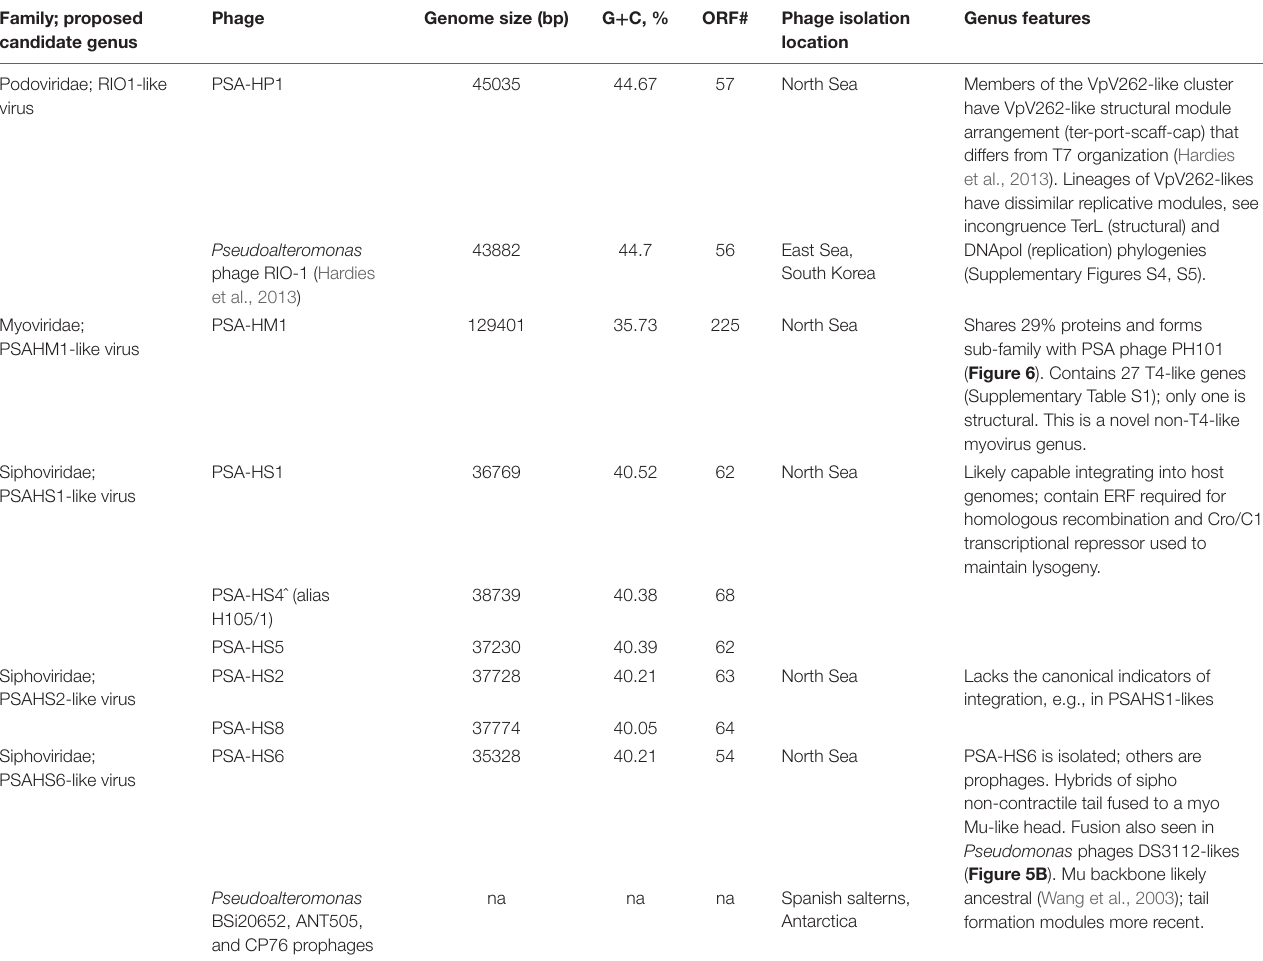
TABLE 1 | Overview of Helgoland Pseudoalteromonas phage genera features. Family; proposed candidate